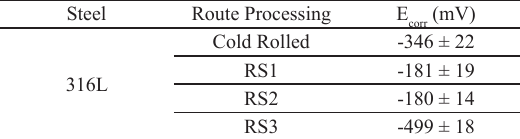
Table 3. Potential for open circuit corrosion of the 316L stainless steel under the cold rolled and rapid solidification conditions in